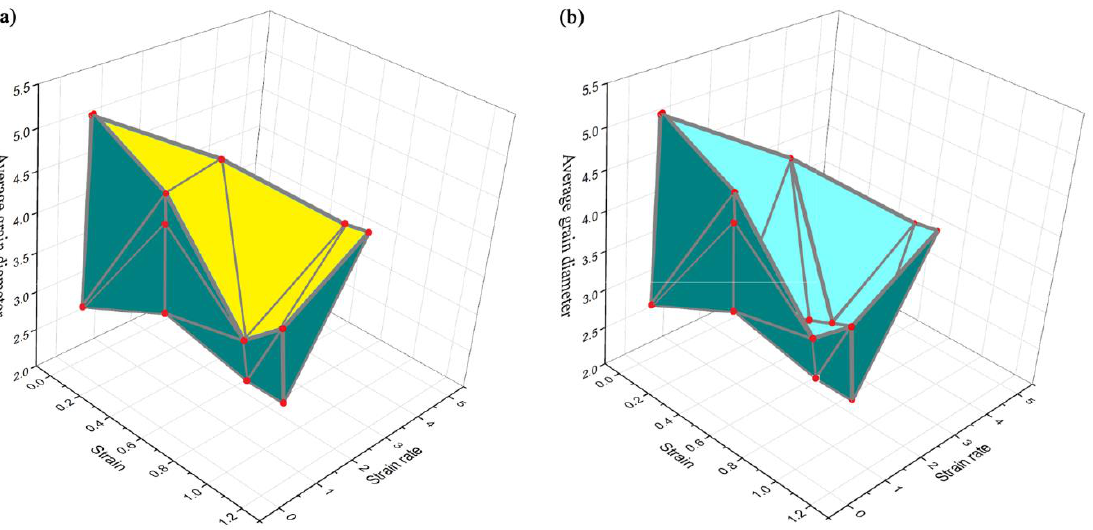
Figure 13. ( a ) Constructing a surface approximated by planes and ( b ) the finally constructed surface based on experimental points. The light color in ( b ) shows the planes that are hidden by the yellow planes in ( a ).